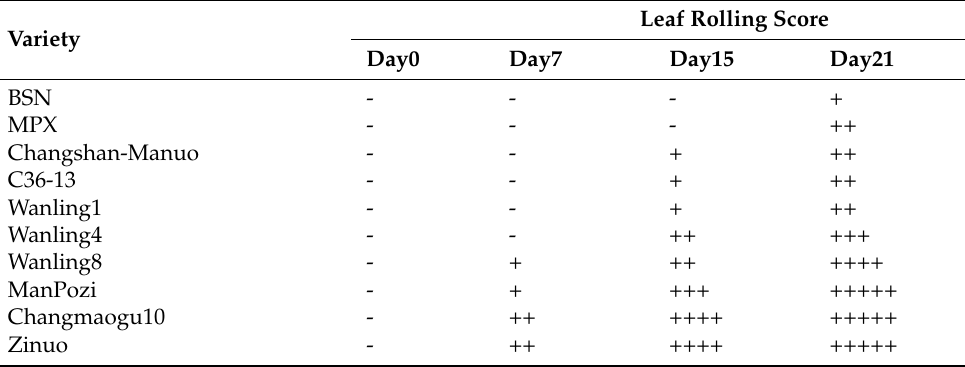
Leaf Rolling Score